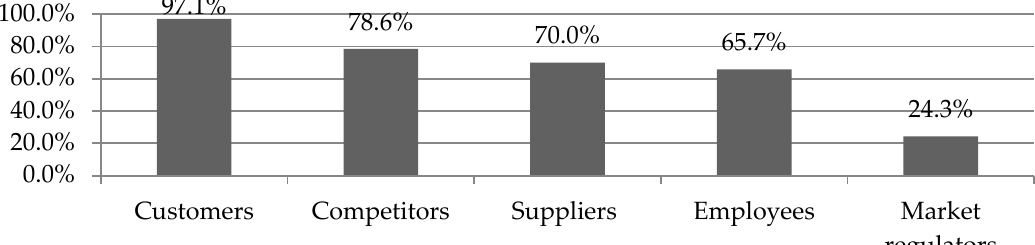
Figure 4. Sources of company information (percentage share—possibility to choose several answers). Source: own study based on the research on the enterprises.